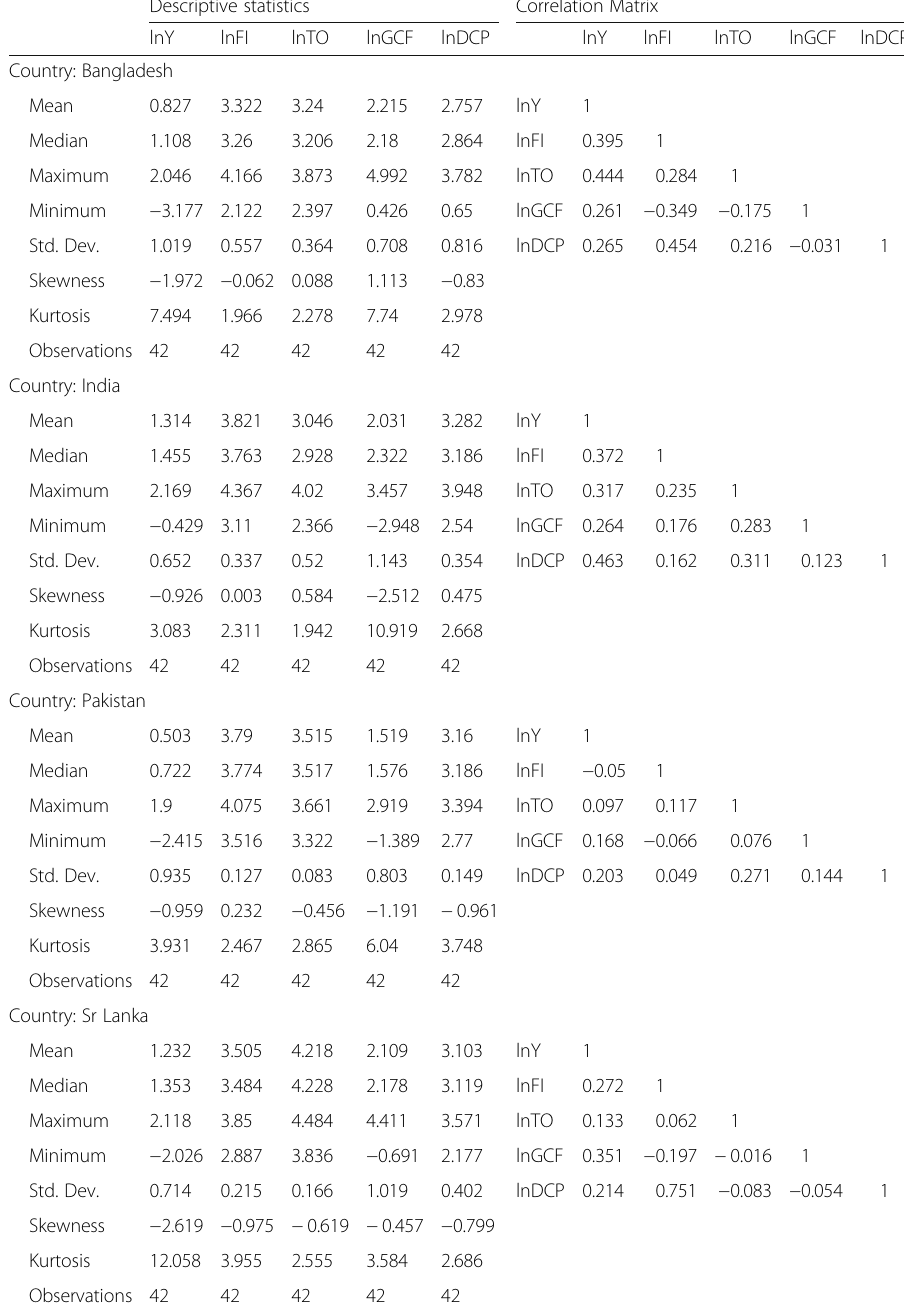
Table 1 Summary of descriptive statistics of research variables Descriptive